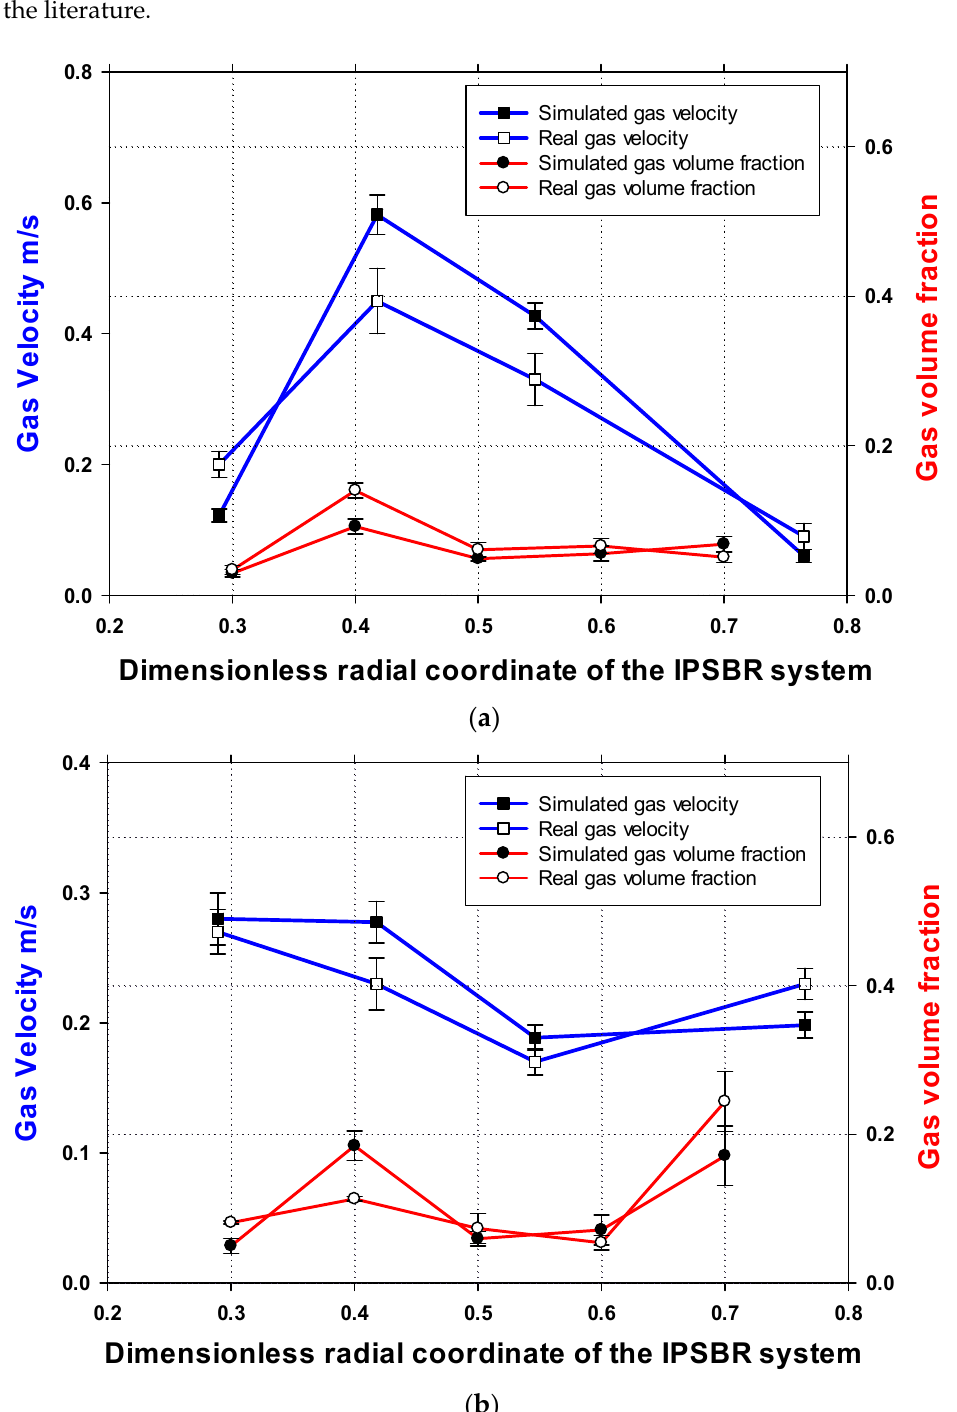
Figure 11. Experimental and simulation results at certain points for air velocity and air volume fraction ( a ) with mixing particles and ( b ) without mixing particles. Table 6. Experimental and simulated average gas velocity and volume fraction with and without mixing particles and calculated error deviation (5–10%).